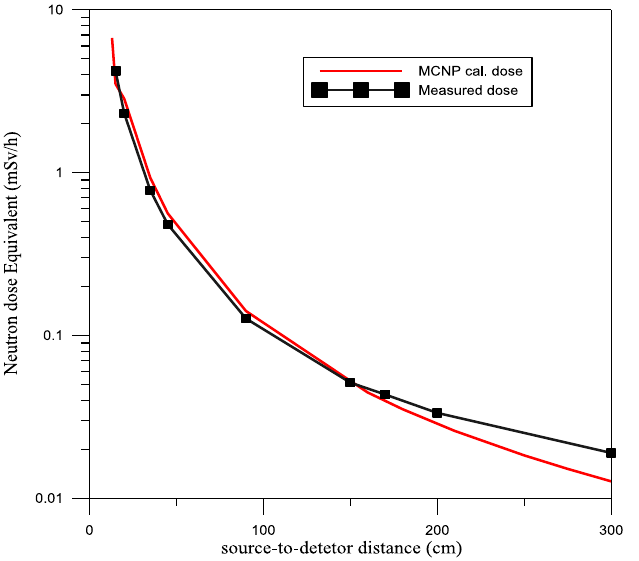
Fig. 3. A comparison between the calculated and measured neutron dose rate at different source-to-detector distances.